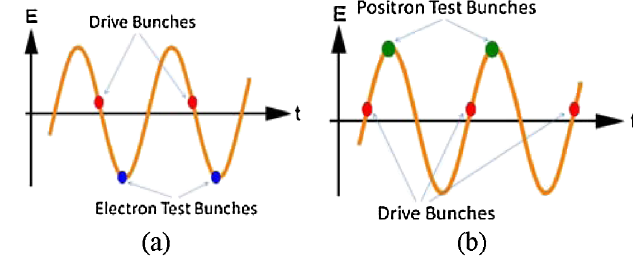
FIG. 9. (Color) (a) Accelerating test electron bunches (blue dots) and decelerating electron drive bunches (red dots). (b) Accelerating test positron bunches (green dots), and decel- erating electron drive bunches (red dots), for a structure consist- ing of a chain of detuned cavities.